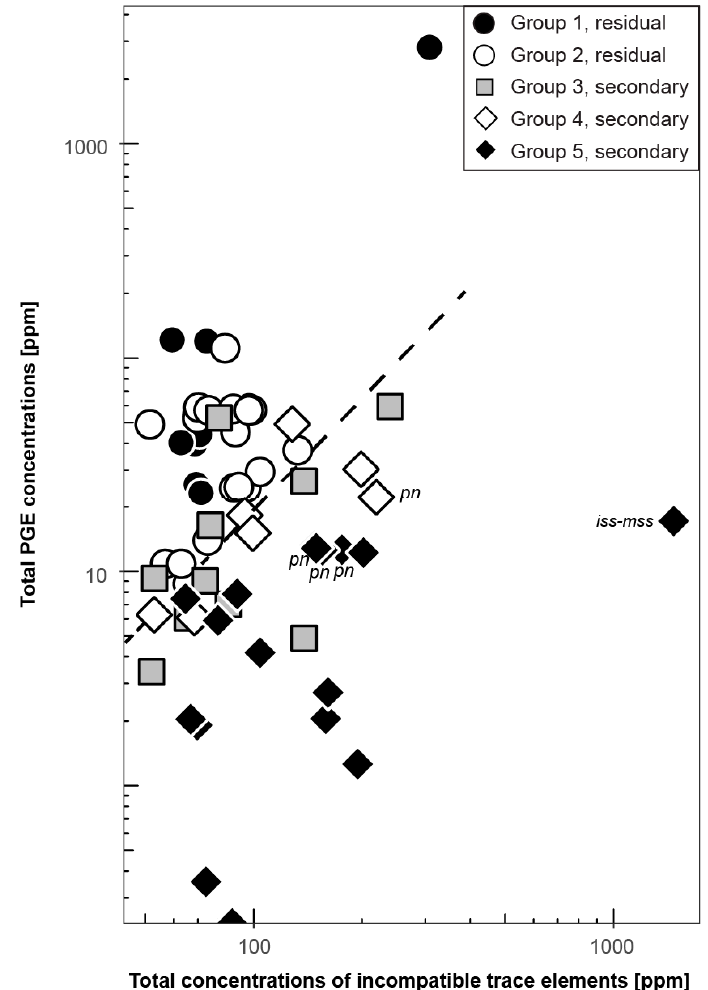
Figure 7. Comparison of total PGE abundances and total concentrations of trace elements incompatible in mss (i.e., Zn, Ag, Pb, As, Sb, Sn, Se, Te, Cd, and Au; Liu and Brenan [41]; Helmy et al. [45]). The broken line roughly delimits the characteristics of sulfides with primary and secondary PGE patterns. Residual mss generally have higher PGE abundances than secondary sulfides (Groups 3, 4, and 5). Secondary sulfides typically are comparatively enriched in incompatible trace elements. Data are from mss unless otherwise stated. Pentlandite is abbreviated as pn.